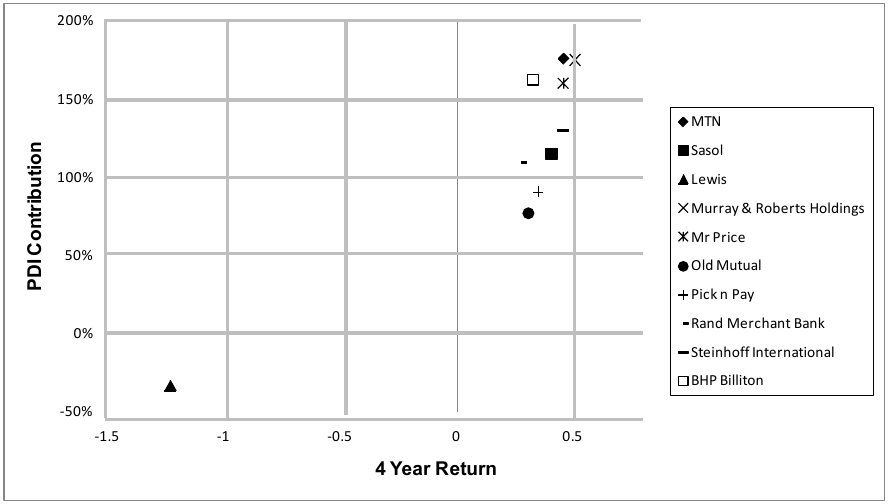
FIGURE 7: 4-year annual returns versus PDI contribution Source: Compiled by